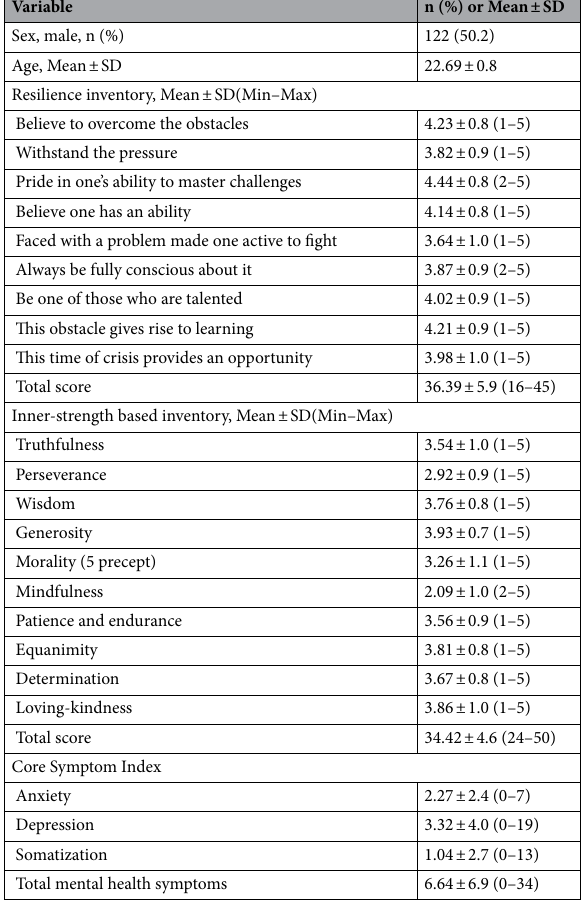
Table 2. Sociodemographic of the participants. SD = Standard deviation.